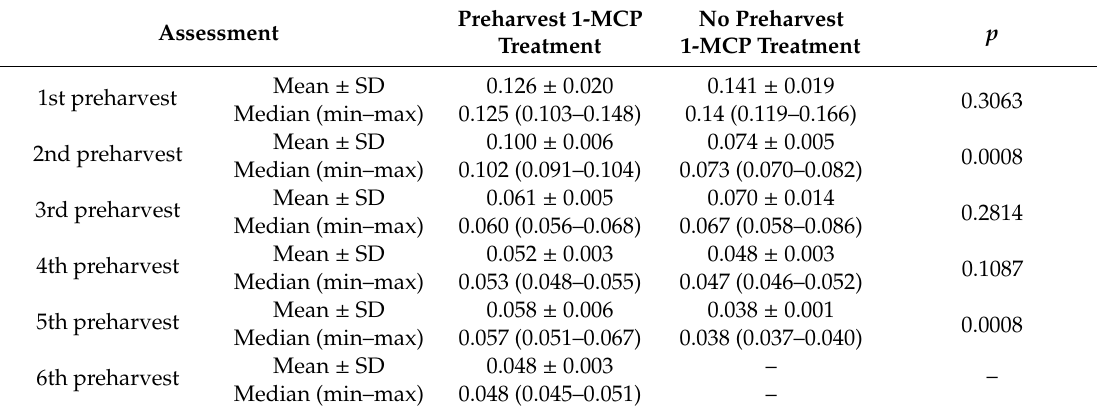
Table 6. Results of Streif index measured for ‘Szampion’ cultivar apples in the preharvest period compared for the group treated with 1-MCP and the control group not treated with